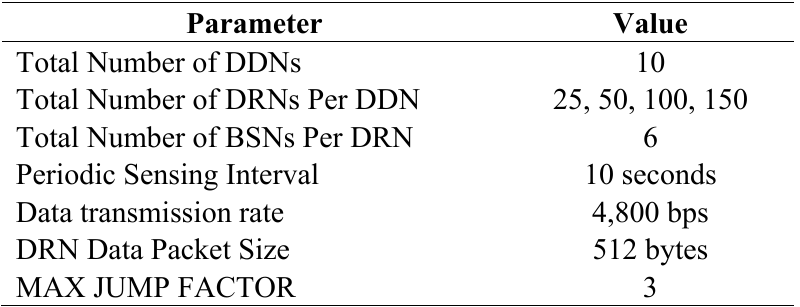
Table 1. Case study simulation